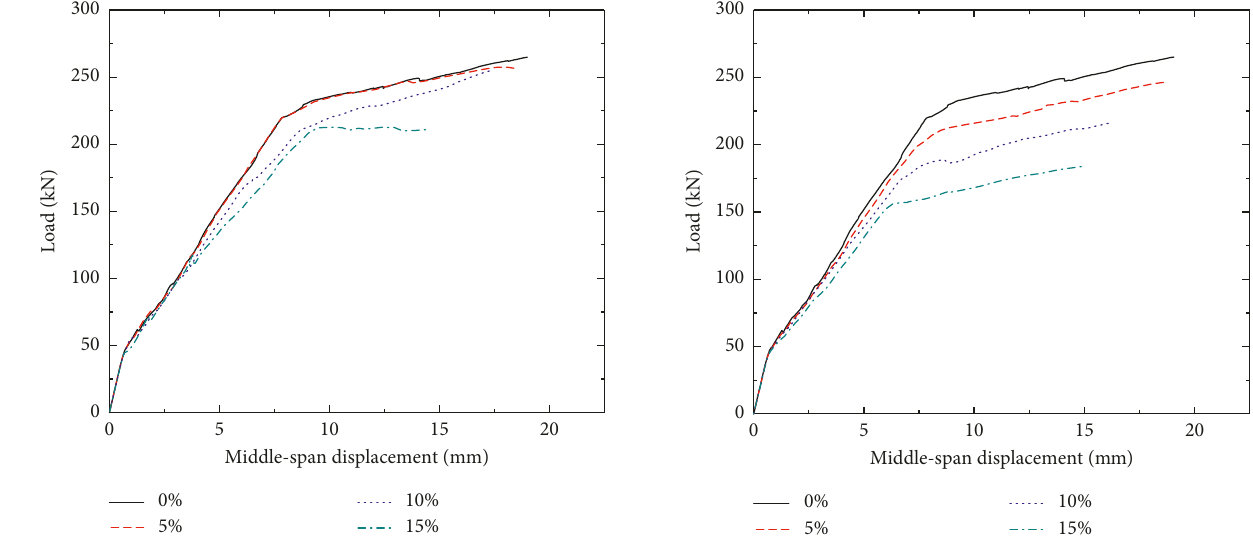
Figure 12: The load-displacement curve due to rebar mechanical property